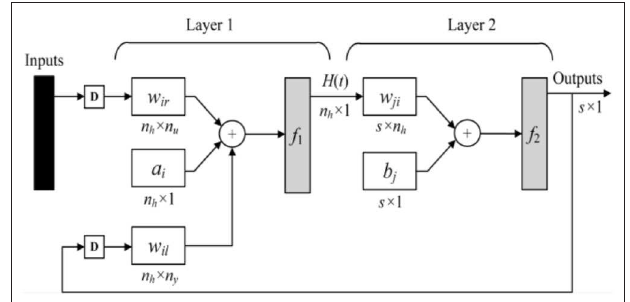
FIGURE 2 | NARX neural network structure with s outputs.